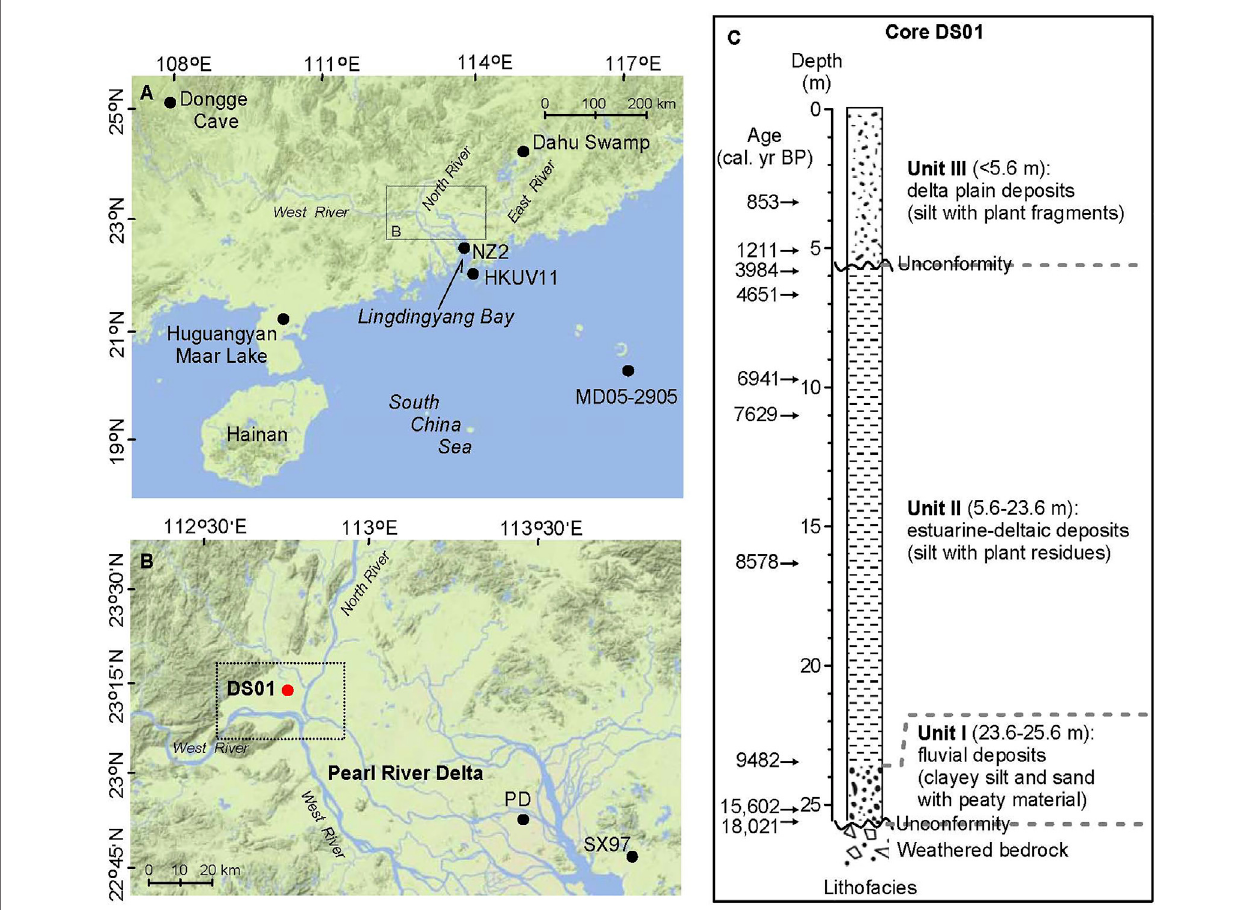
FIGURE 1 | Location map (A,B) and stratigraphic information (C) for sediment core DS01 (red circle) in the head area (dotted rectangle) of the Pearl River deltaic plain.Blackcirclesmarkthelocationsofsitesdiscussedinthetext: DonggeCave(Wangetal.,2005),DahuSwamp(Zhouet al.,2004),HuguangyanMaarLakeinsouth China (Wang et al., 2016), core HKUV11 (8.4 m water depth, Wu et al., 2017), core MD05-2905 (1,647 m water depth, Zhou et al., 2012) in the northern South China Sea,coreNZ2(4.6 mwaterdepth)inLingdingyangBay(PearlRiverestuary,Wuetal.,2021),and corePDandcoreSX97fromthebanksofthePearlRiverestuary (Yangetal.,2008;Pengetal.,2014).The10radiocarbondatesforcoreDS01shownin (C) arefromFuetal.(2020).Detailsofthemethodsusedtoproducetheagedata are given in Xiong et al. (2018). The maps were produced using Tencent Map App.